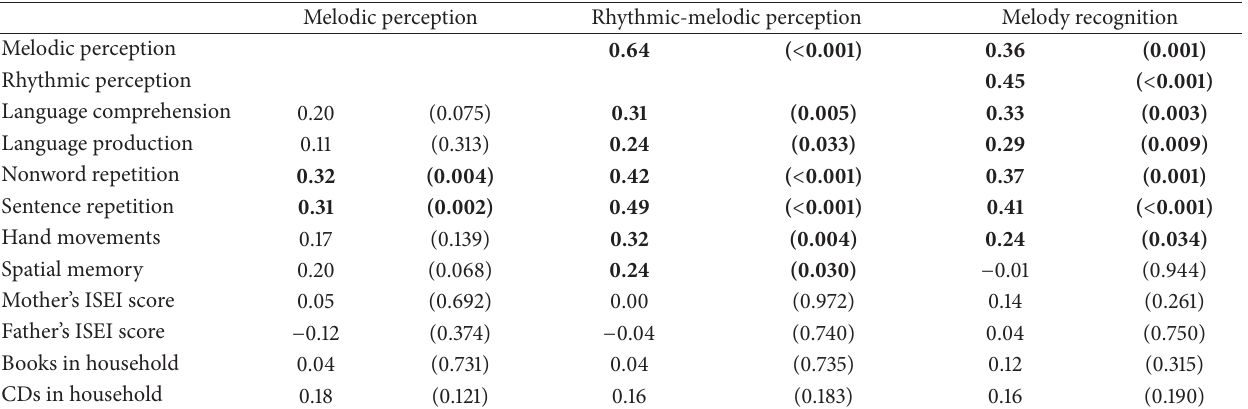
Table 4: Intercorrelations of the music perception subtests (top part), as well as correlations of the music perception subtests with the subtests of the language screening (middle part) and with indicators of the socioeconomic background of the participants. Correlations are reported for the whole group (SLI, CA, and CL), their significance level is shown in parentheses, and significant correlations are indicated by bold